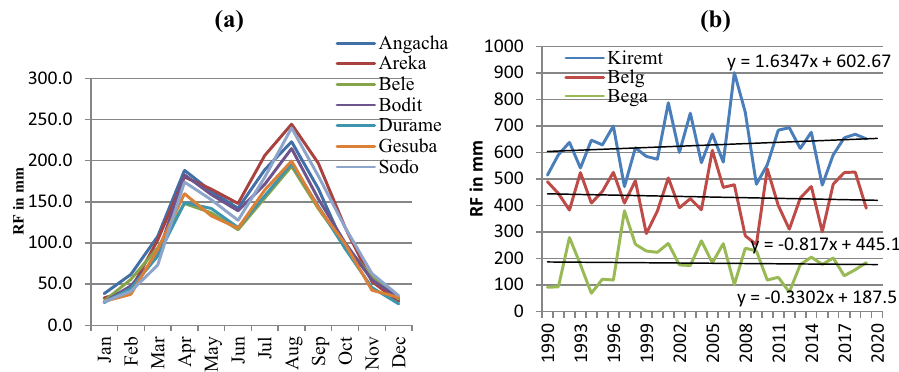
Fig. 6 a Monthly mean of each stations and b Seasonal mean RF trend of the watershed